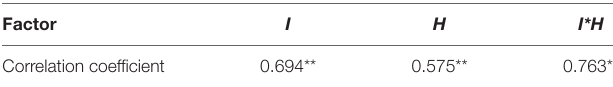
TABLE 4 | Correlation coefficients between soil loss rate with coupling effects of rainfall intensity and initial thawed depth. Factor I H I*H Correlation coefficient 0.694** 0.575**